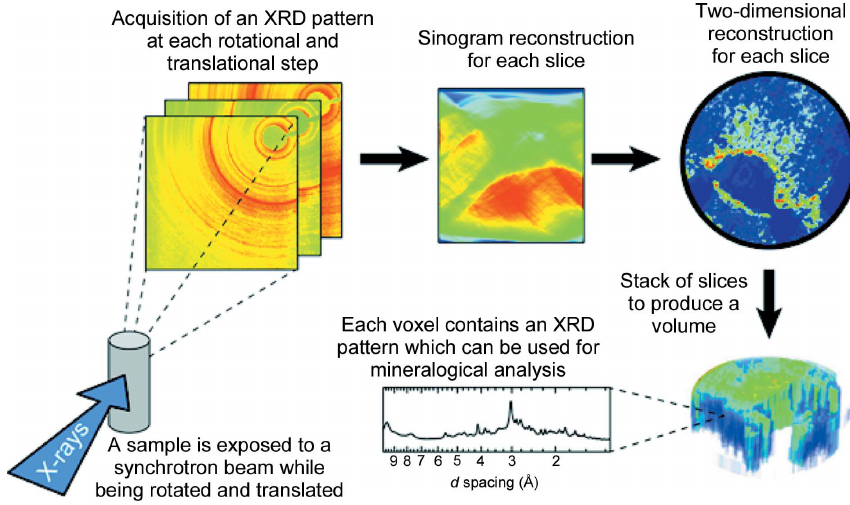
Figure 1 Schematic representation of an in situ synchrotron XRD-CT experiment. A slice corresponds to a height of 10 m m and a width of approximately 1.6 mm, i.e. 180 (rotation steps) (cid:2) 160 (translation steps parallel to the beam) images. For the sample cured for six months, three slices were recorded (10 m m translation perpendicular to the beam). A sinogram represents the scattered intensity within one particular scattering